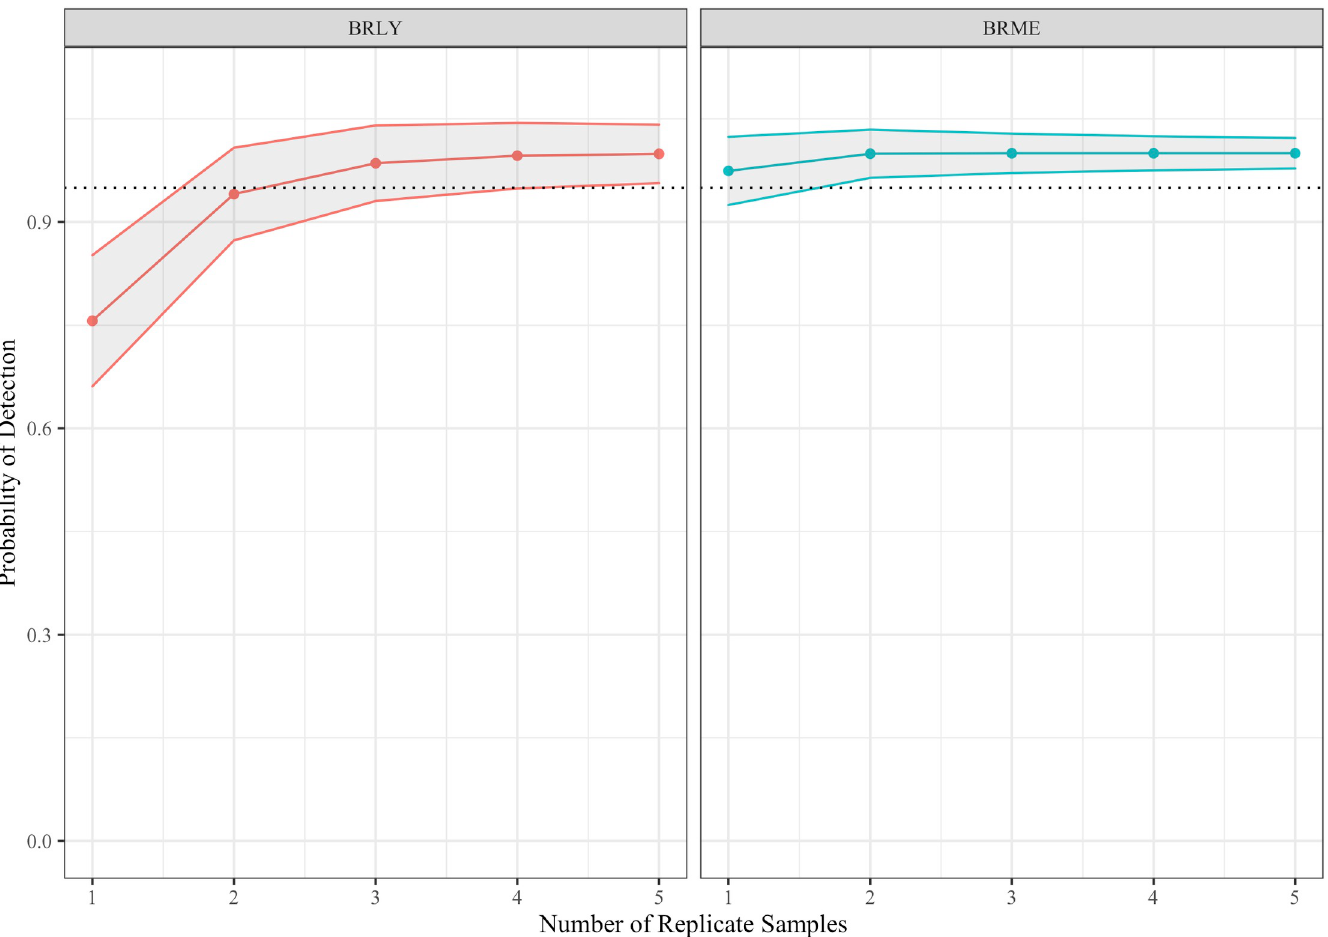
Fig 2. Probability of detection for BRLY and BRME using eDNA sampling with varying numbers of replicate water samples. Dotted line represents 95% detection probability.